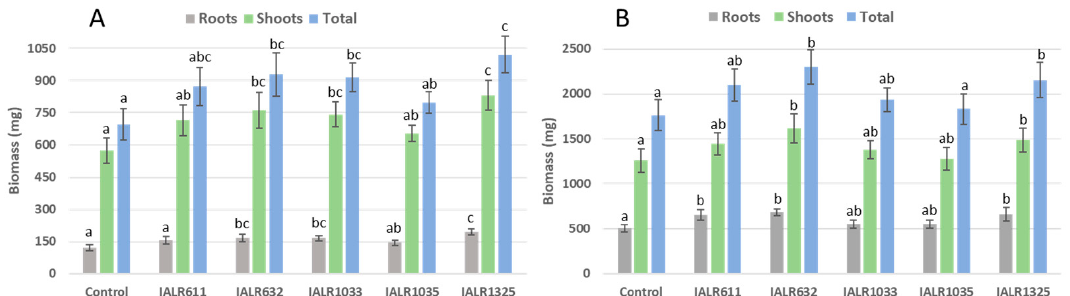
Figure 4. Phosphate solubilizing bacteria promoted the growth of pepper ( A ) and tomato ( B ) plants. Different letters on bars mean significantly different at p < 0.05.